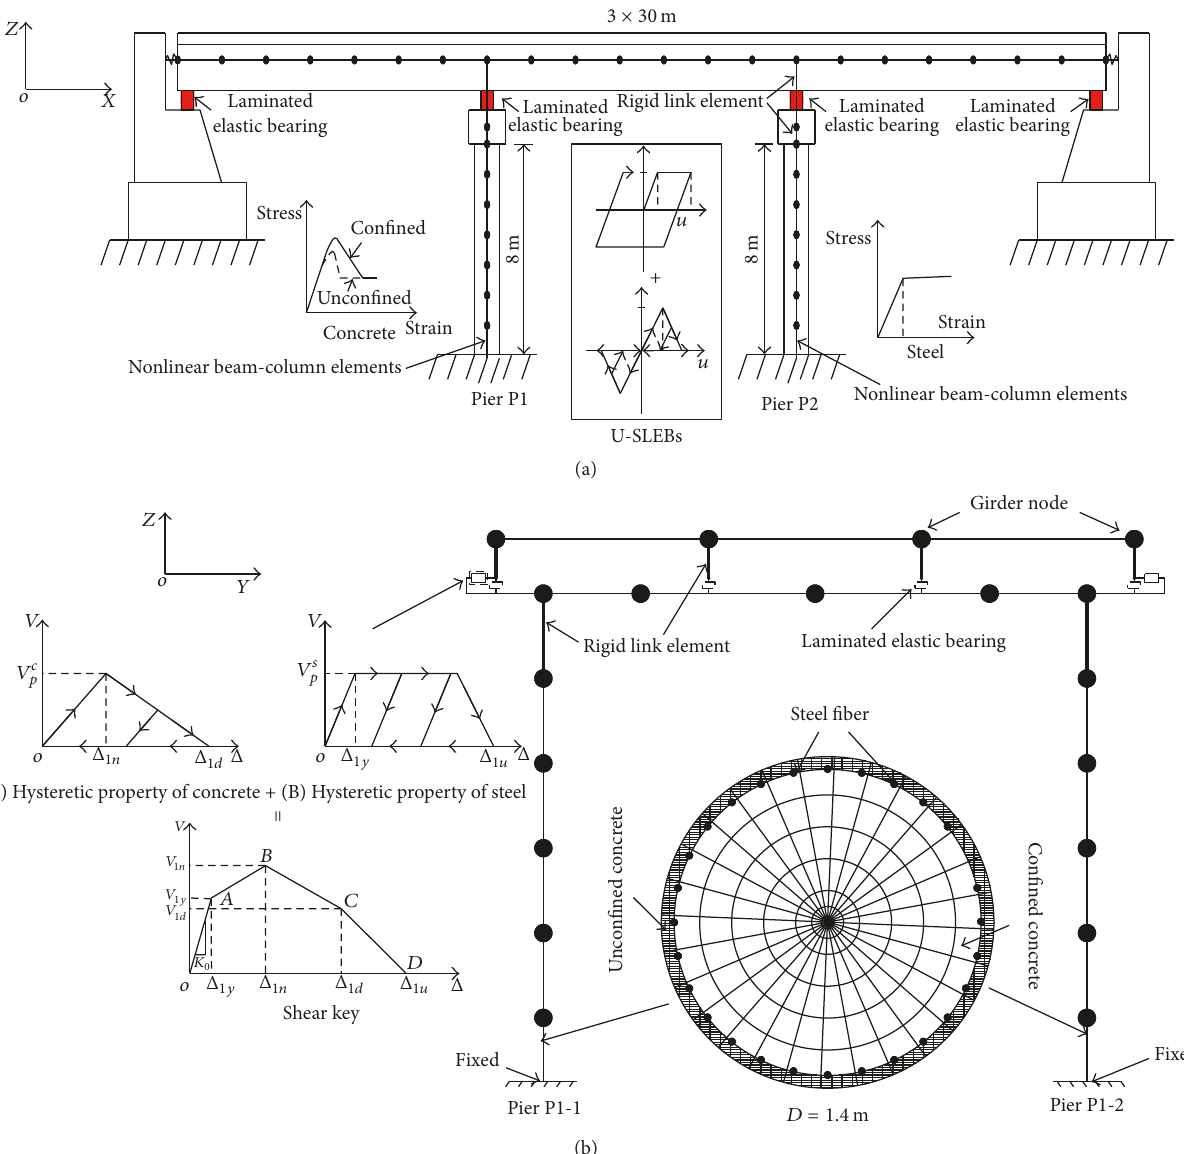
Figure 17: Finite element models of the prototype bridge: (a) elevation view; (b) bent elevation at pier P1.